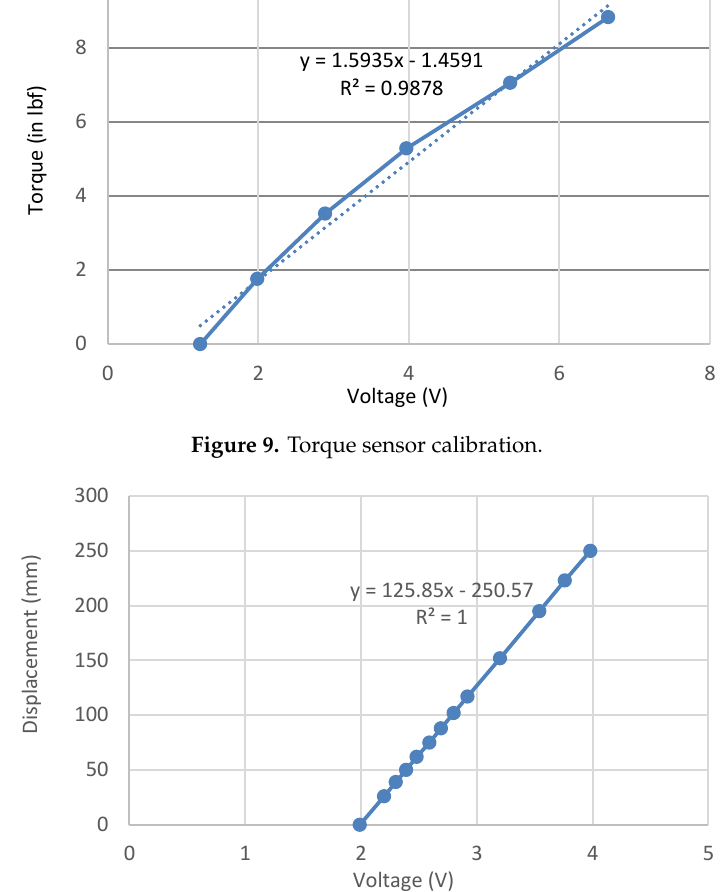
Figure 8. Load cell calibration.